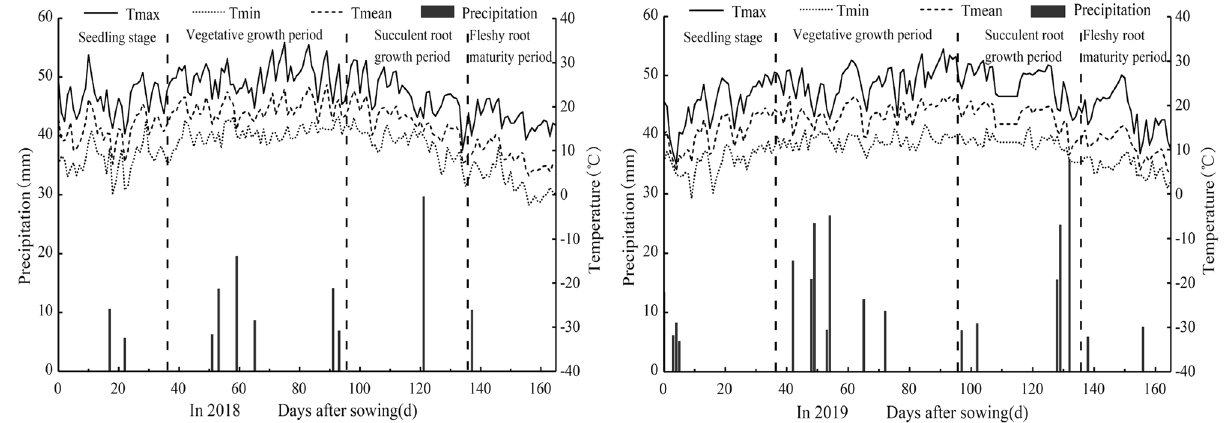
Figure 1. Distribution of monthly rainfall at the experimental station in 2018 and